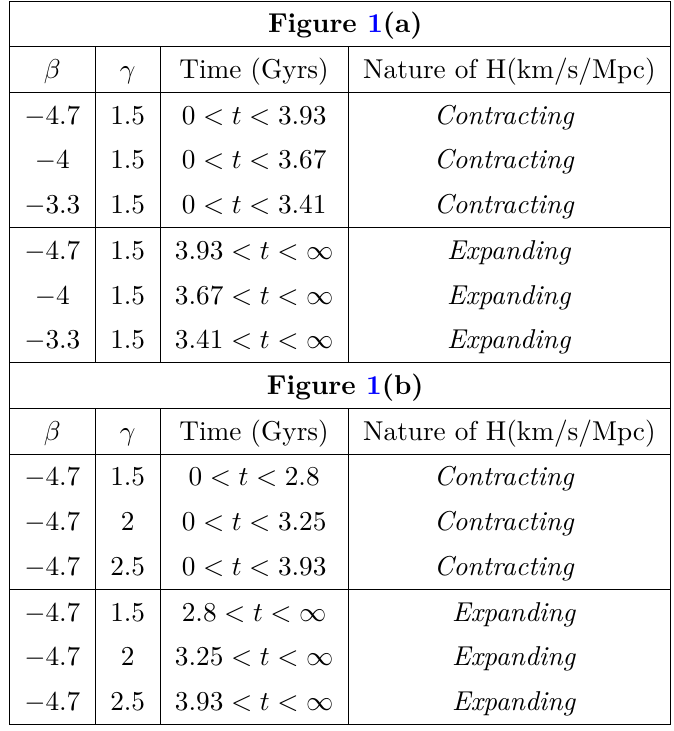
Table 1. Constraints on the model